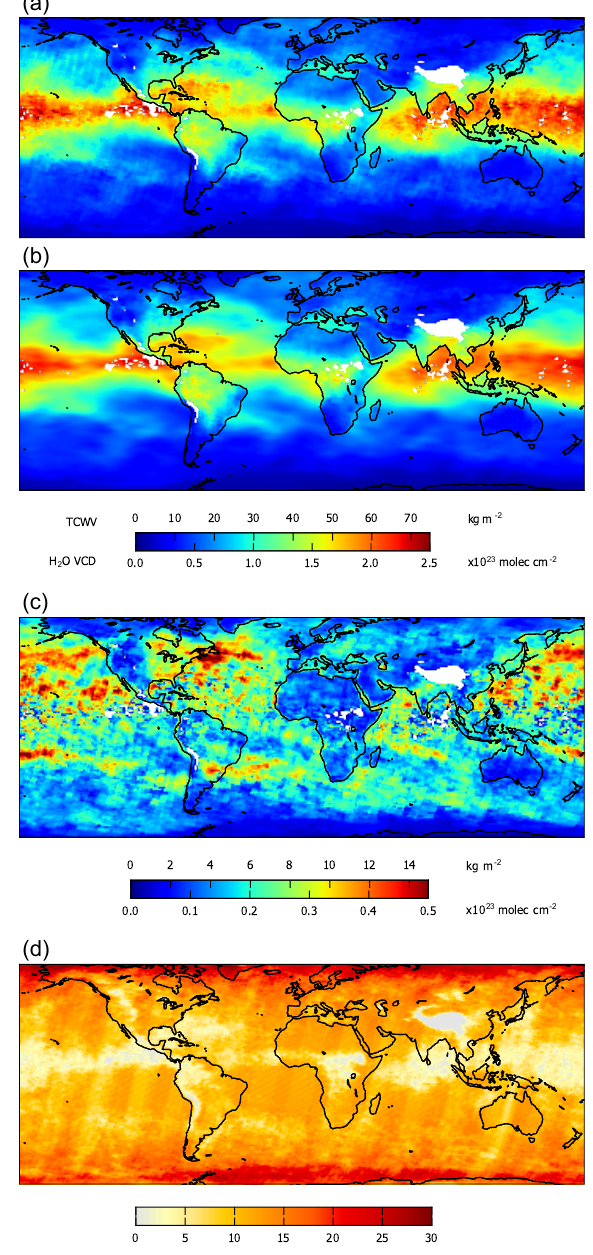
Figure 10. Climate product maps for September 2015 of the TCWV V (a) , the TCWV smoothed over ocean V (cid:48) (b) , the standard deviation of monthly TCWV σ (c) , and the number of available days N (d)